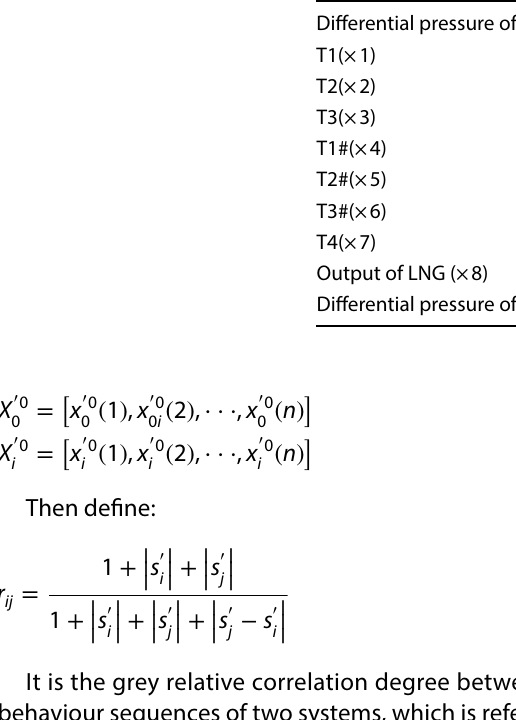
Table 3 Analysis of sequence